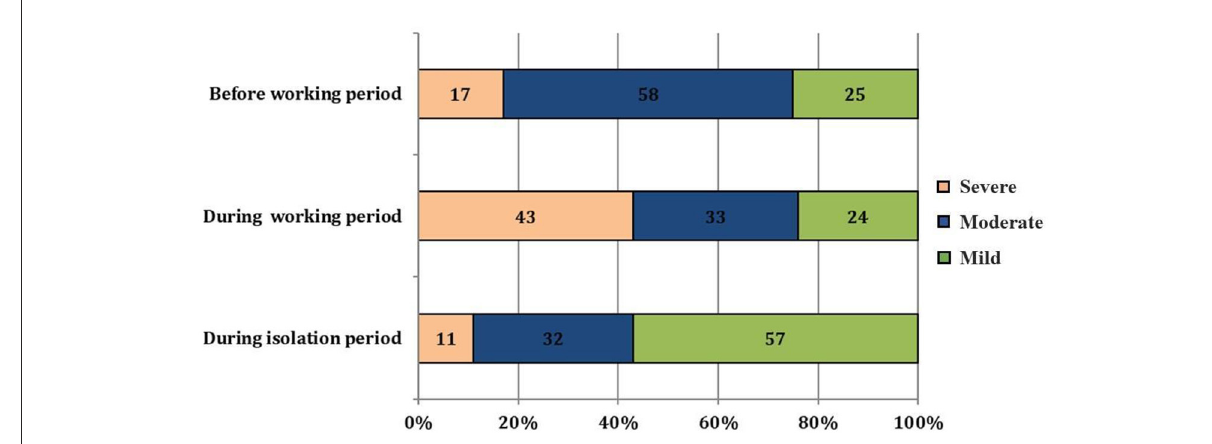
FIGURE1 Self-declared sleep disorder severity of study participants.